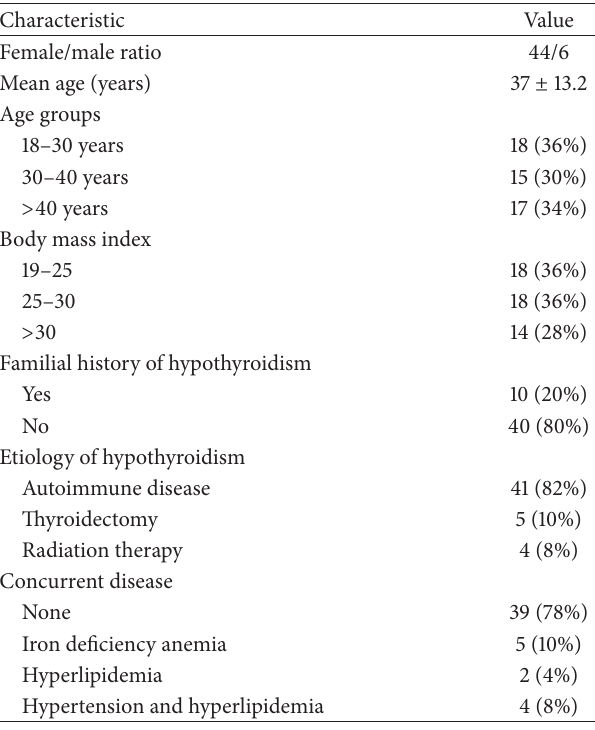
Table 1: Demographic characteristics of the patients ( 𝑛 = 50 ). Table 2: Changes to the serum levels of TSH during the study (all data are reported as mean ± SD).